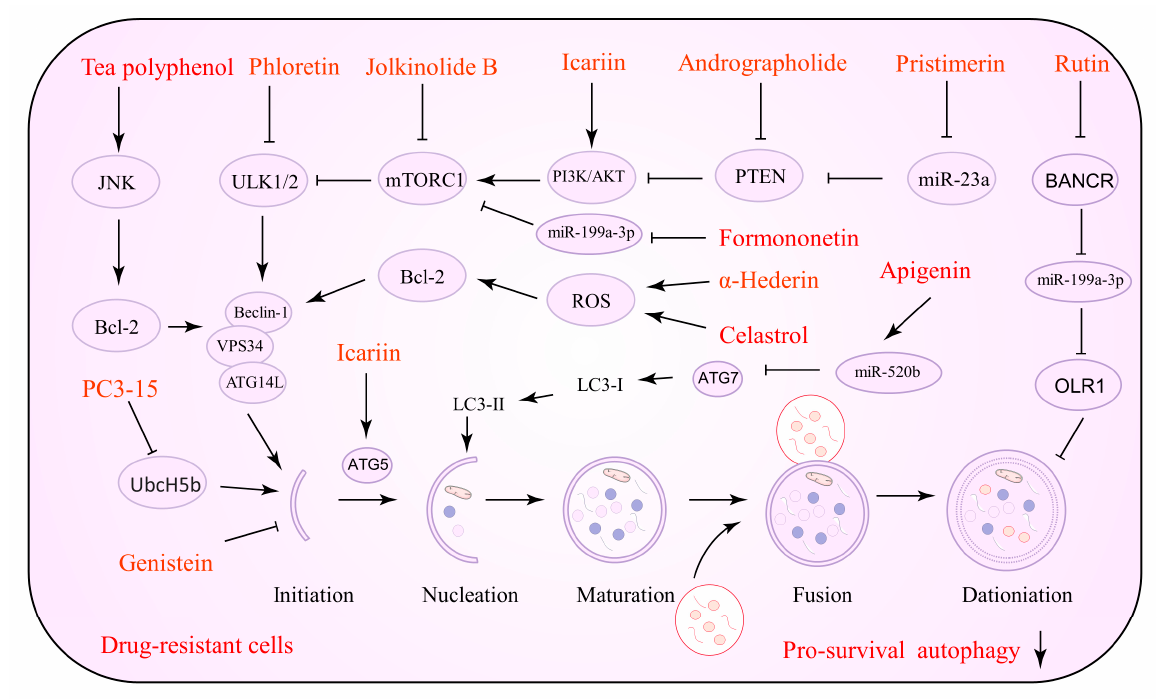
Figure 2. Natural products against tumor drug resistance by inducing lethal autophagy. Alkaloids are NPs of importance with potential value in cancer therapy. Alkaloids have been demonstrated to impact malignant cancer cell proliferation and work in tandem with chemotherapeutic drugs. Berberine (BBR), as observed by Zhang and his group, downregulates the c-Myc signaling pathway and increases ROS production, which causes an increase in the sensitivity of lapatinib [84]. BBR is an alkaloid capable of upregulating basal autophagy and inducing hyperautophagy. Its properties make BBR essential for malignant proliferation and drug resistance in cancer research [85]. BBR may modulate autophagic flux and apoptosis in drug-resistant cells. In this sense, BBR downregulates the ERK1/2 signaling pathway that induces intracellular ROS accumulation and EGFR degradation, all of which have been linked to chemotherapy and targeted therapy sensitivity [86,87]. Matrine is an active component of the botanical drug Sophora flavescens, which exhibits potent anti-tumor properties. Matrine targets ATGs and affects the cell cycle of tumor cells, enhancing the sensitivity of drug-resistant cells to vincristine (VCR) and adriamycin (ADM) [88].